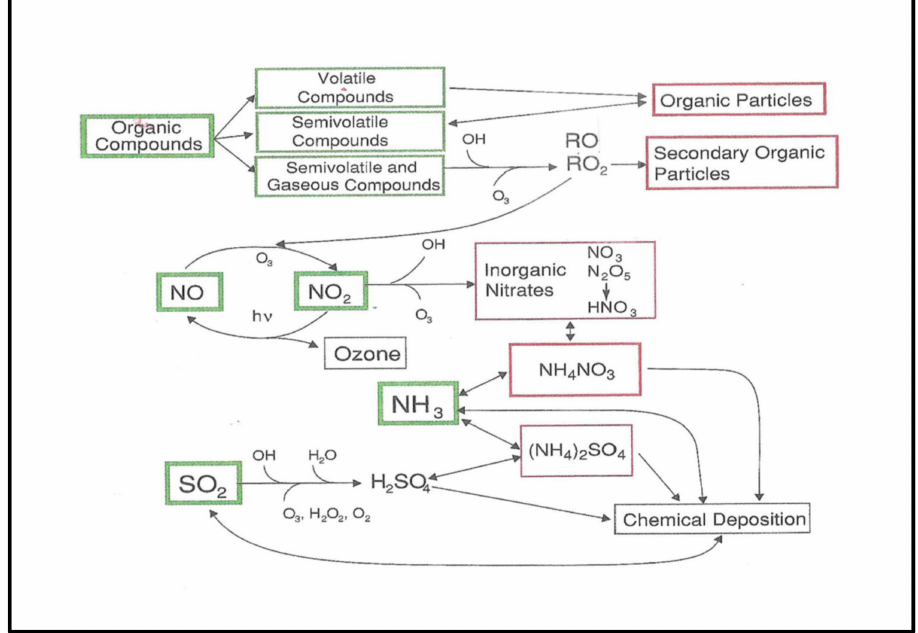
Figure 1. Schematic diagram for gas phase and particle interactions in common chemical cycles relevant to the urban atmosphere, for example, the photochemically related cycle. Note the gas phase dominance to produce O 3 and the aerosol linkages to SO 2 , NO x oxidation and OC production in the upper right. (From [22]; courtesy of Cambridge University